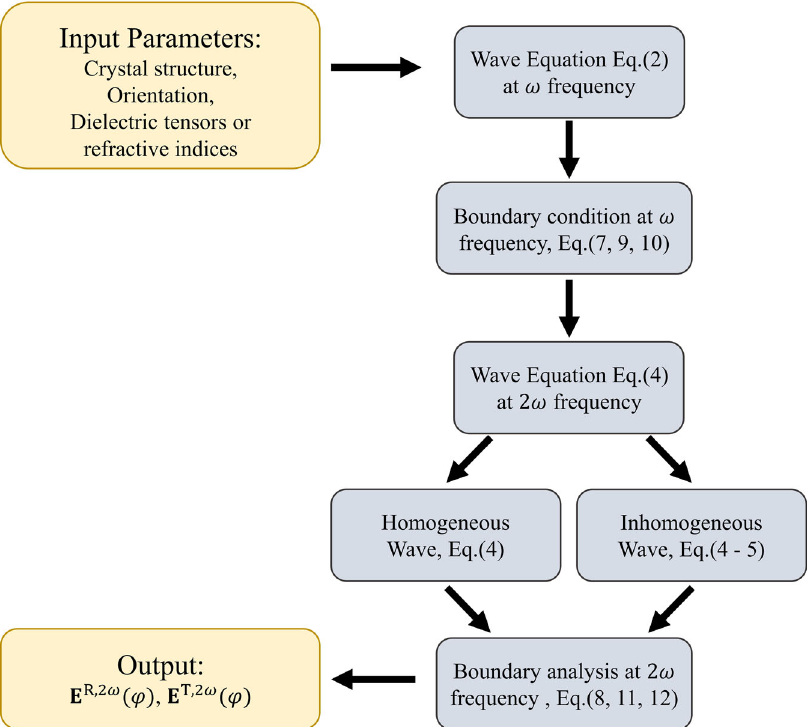
Fig. 3 Flowchart of calculation procedures in ♯ SHAARP. Flowchart illustrating the key steps in deriving the polarized second-harmonic fi elds generated by a nonlinear